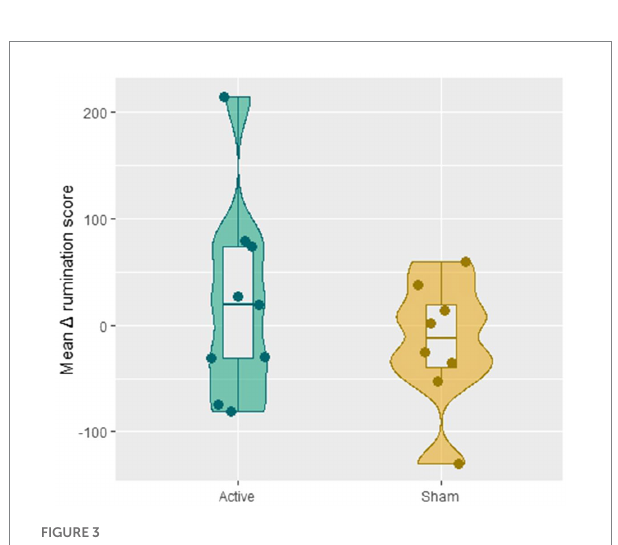
FIGURE 3 The difference in the averaged Δ rumination scores (i.e., the mean of the value C-A) across session 2–8 between the active and sham